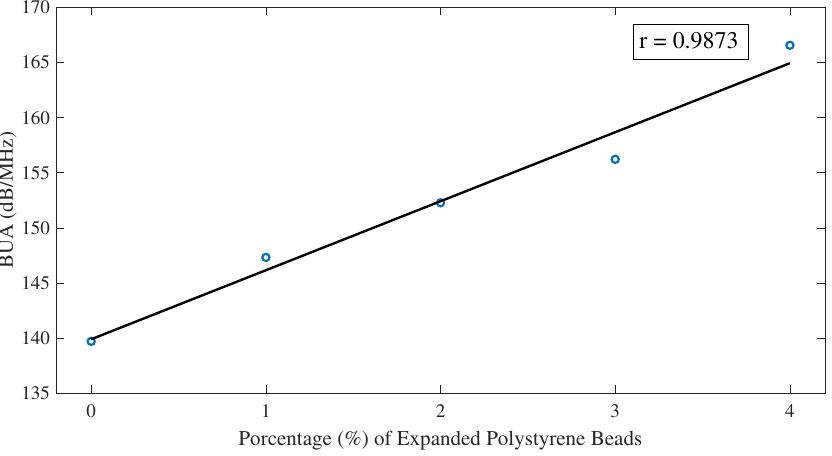
Figure 12. BUA averages over the window of the CFST samples. The solid black line is a linear fit of the data. Pearson correlation coefficient r =